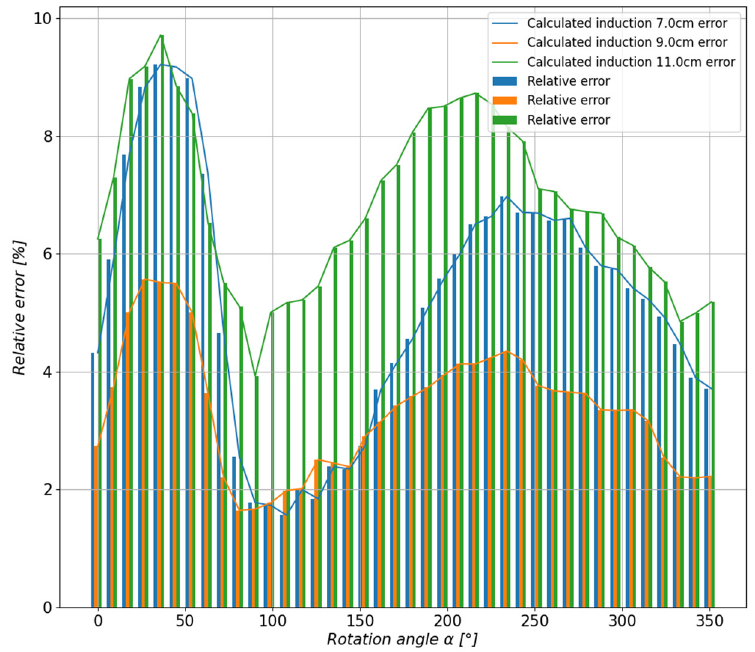
Figure 24. The comparison of the relative errors of the estimated values at the control points of the permanent magnet system.